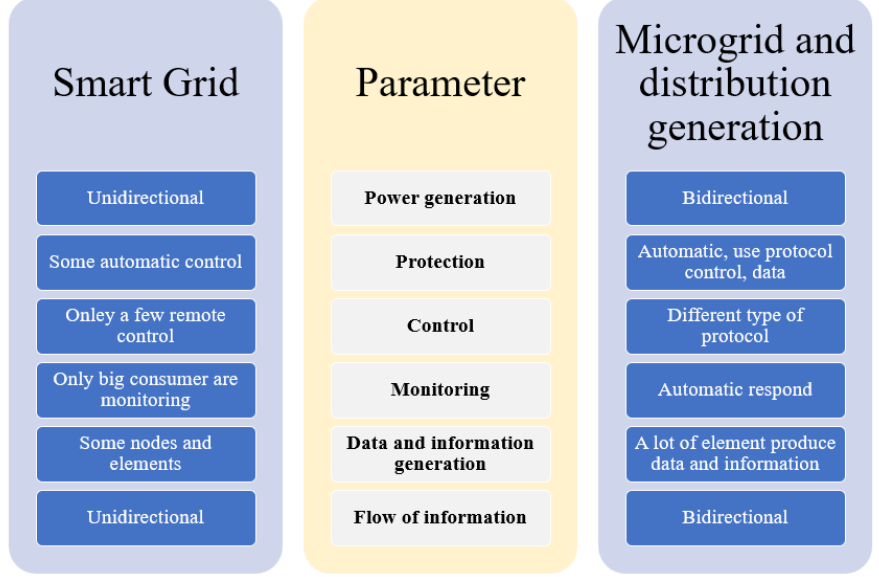
Figure 4. Comparison of communications systems in microgrids and smart grids.